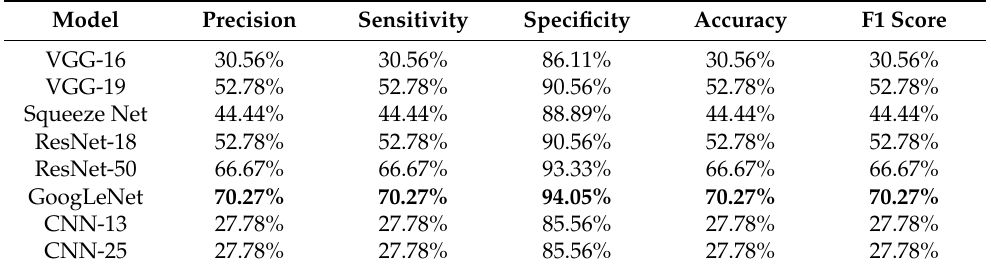
Table 3. Performance metrics of retrained models and typical CNN models without data